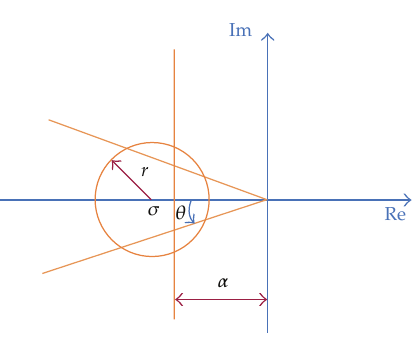
Figure 2: Illustration of LMI